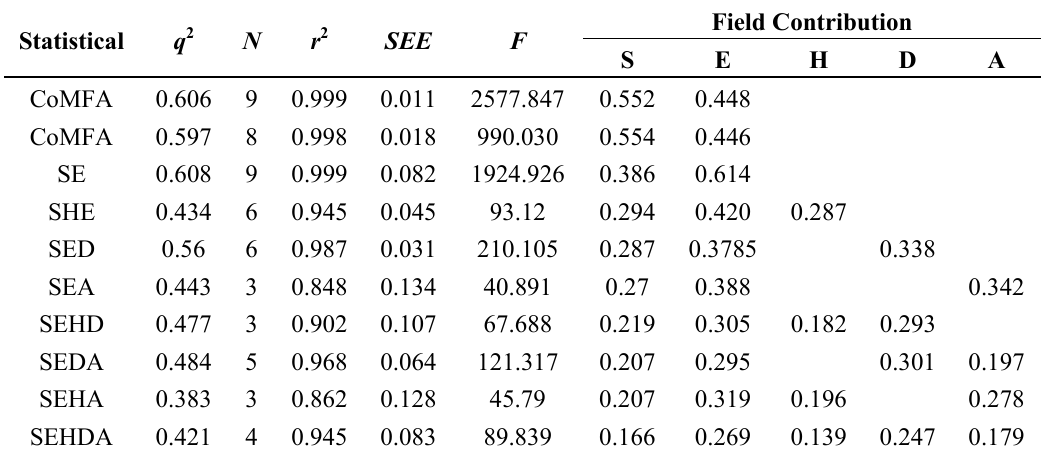
Field Contribution